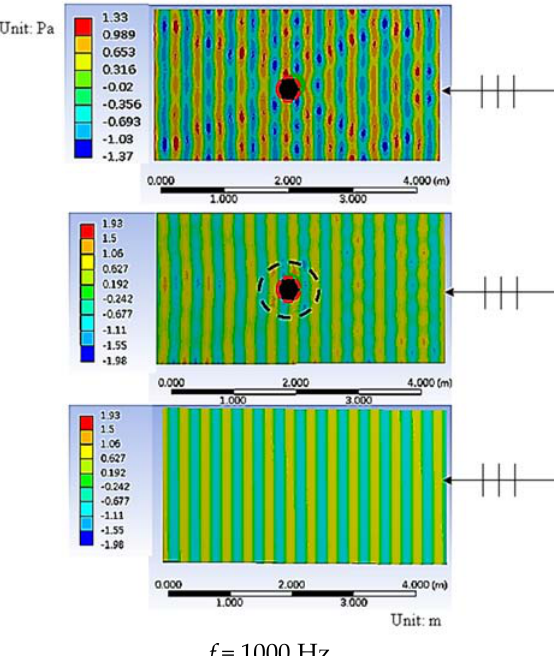
Figure 13. Wave field of uncloaked object (upper plot), cloaked object (middle plot), and free field at 1000 Hz. Plane waves with a specific frequency propagate from right to left. The dotted lines indicate the geometry of the cloaked object and cloak shell. Appl. Sci. 2017 , 7 , 456